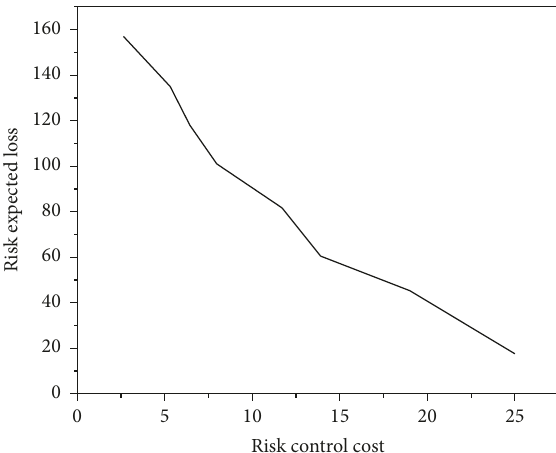
Figure 4: Diagram of V–C without constraints.